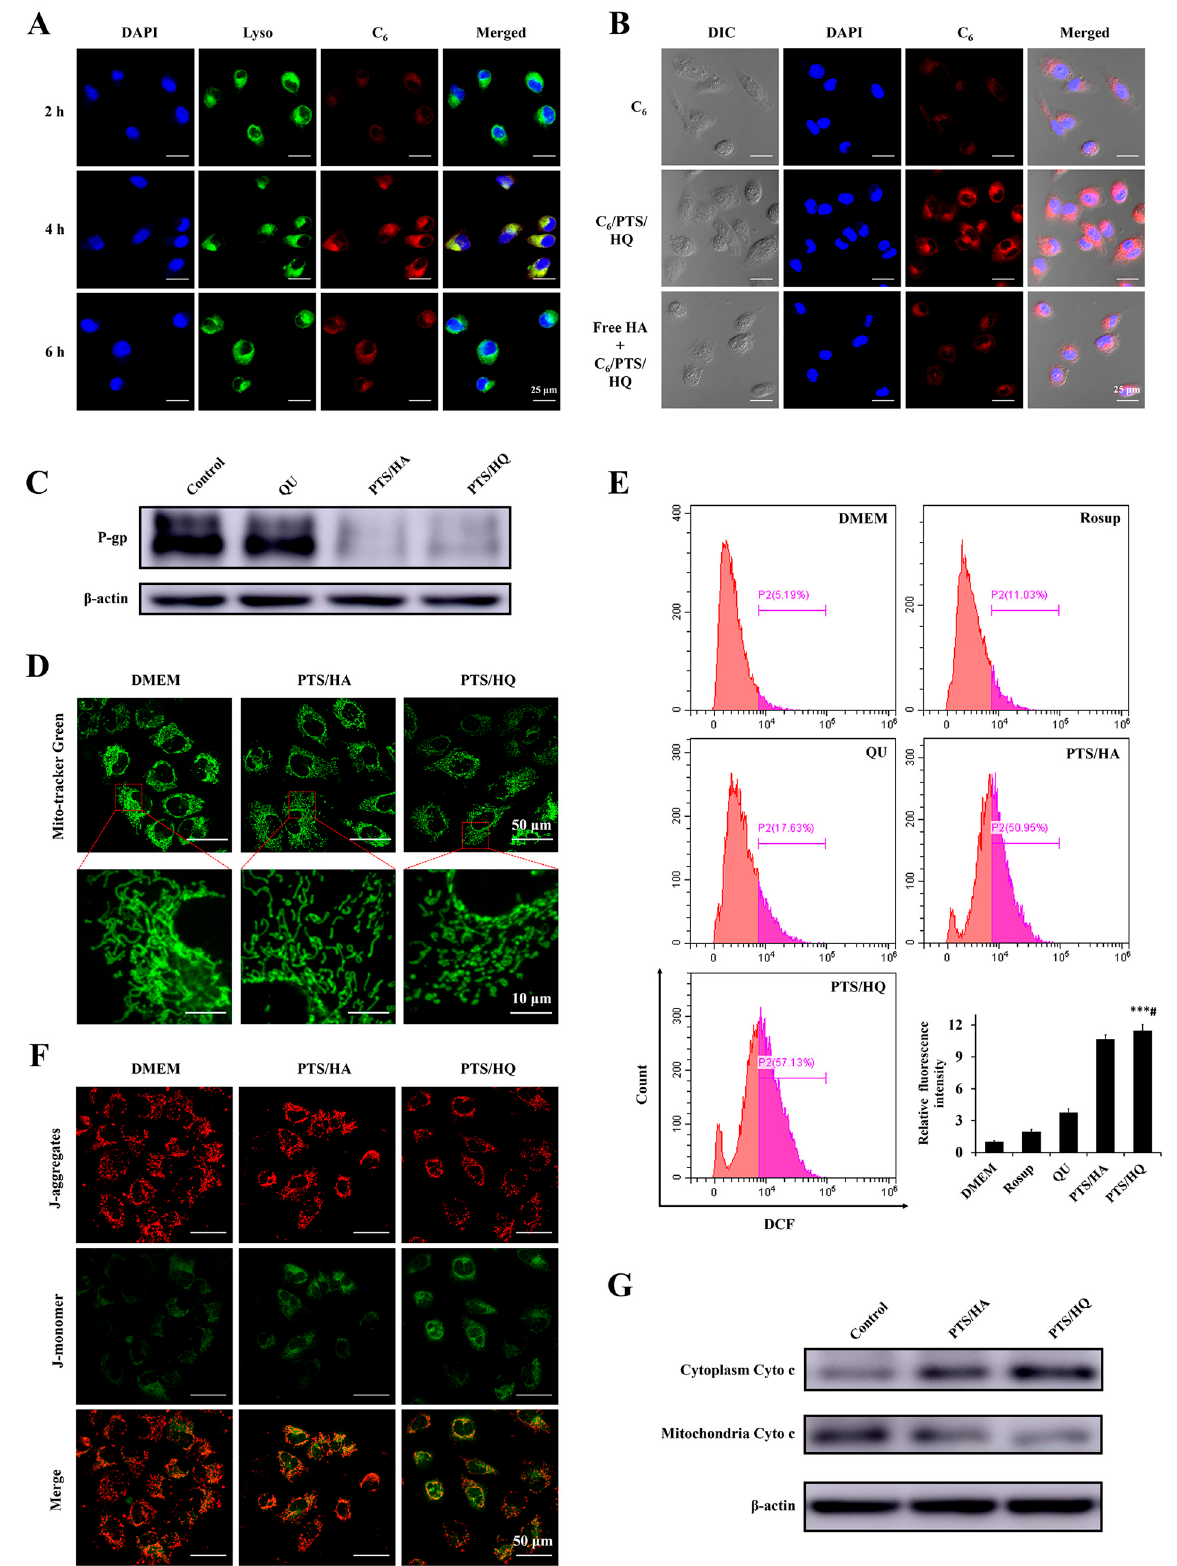
Figure 5. Intracellular mechanisms of drug-loaded PTS/HQ PNPs to combat MDR. ( A ) Lysosomal escape of C 6 /PTS/HQ PNPs observed in MDA-MB-231/DOX cells after 2, 4, and 6 h of treatment. Nuclei and lysosomes were stained with DAPI (blue) and Lyso Tracker (green), respectively. ( B ) Cellular uptake of C 6 by MDA-MB-231/DOX cells after 4 h incubation with C 6 suspension,